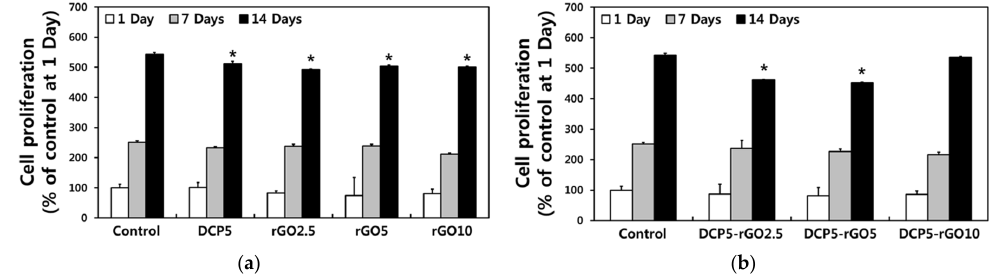
Figure 4. ( a ) Proliferation of MC3T3 ‐ E1 cells treated with 5 μ g/mL of DCP or 2.5, 5 and 10 μ g/mL of rGO. ( b ) Proliferation of MC3T3 ‐ E1 cells treated with DCP ‐ rGO hybrid composite. Cultures with fresh media were used as the negative control. An asterisk (*) denotes a significant difference when compared with the control, p < 0.05.